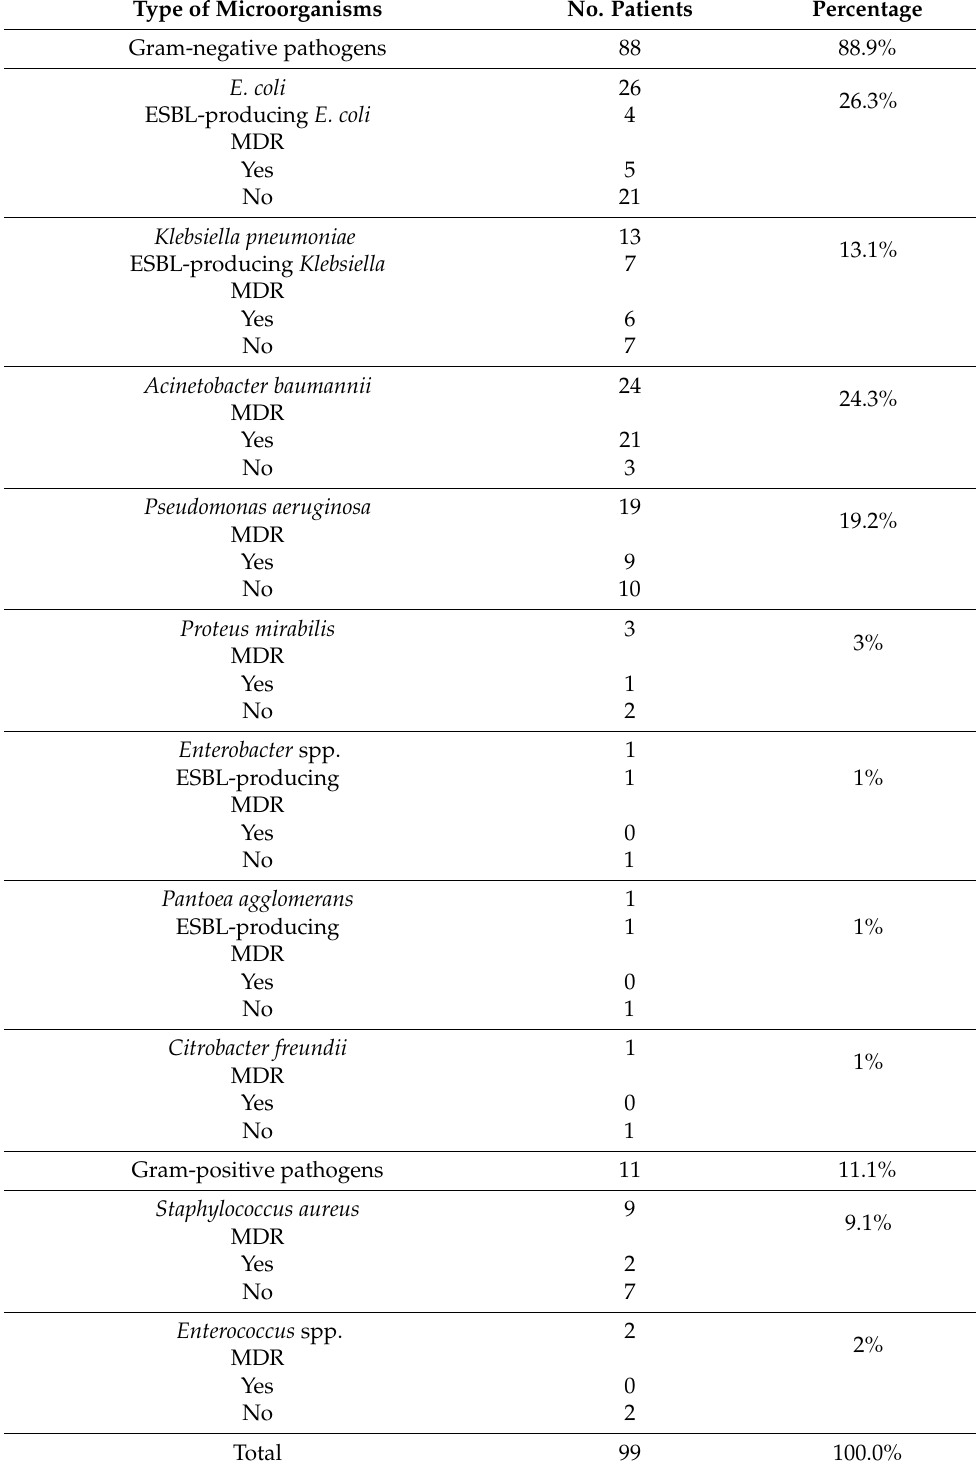
Table 2. Distribution of uropathogens that showed bacterial growth including ESBL and MDR